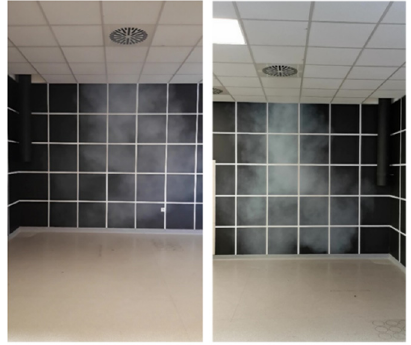
Figure A2 . Air Flow pattern . Figure A2. Air Flow pattern.